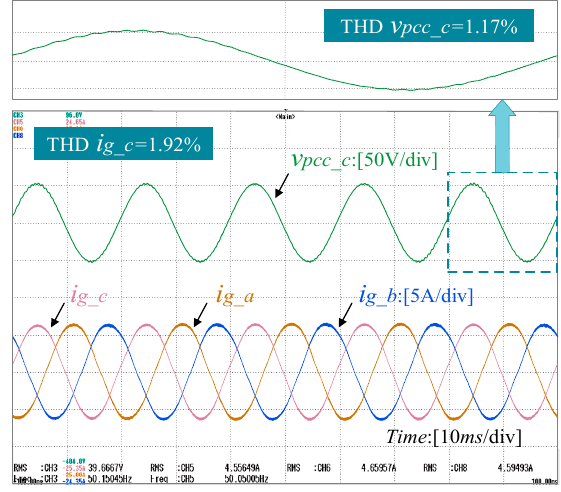
Figure 21. Steady ‐ state responses when L g is 5 mH. Figure 21. Steady-state responses when L g is 5 mH.